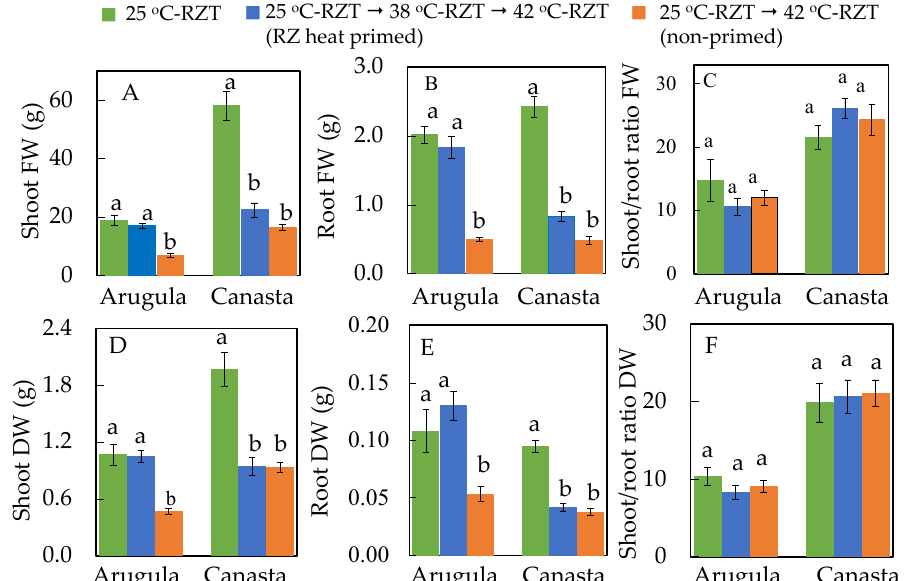
Figure 4. Shoot FW ( A ), root FW ( B ), shoot/root ratio FW ( C ), shoot DW ( D ), root DW ( E ), shoot/root ratio DW ( F ) at harvest (36 DAT). The vertical lines through the means represent standard errors ( n = 4). Different lowercase letters are statistically different ( p < 0.05, Tukey’s multiple comparison test). Each species was analyzed separately. Refer to Section 4.2 for further details on different RZT treatments.